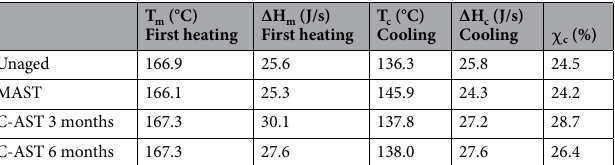
Table 3. Summary of DSC parameters for PVDF-A after C-AST and MAST